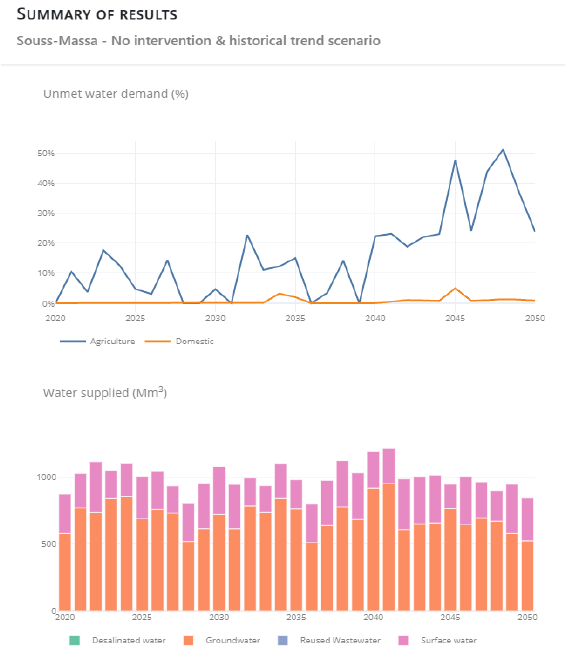
Figure 6 Example of the displayed results of the “ No Intervention ” scenario with 10% share of Solar PV adopted in 2040 (Source: Souss-Massa nexus